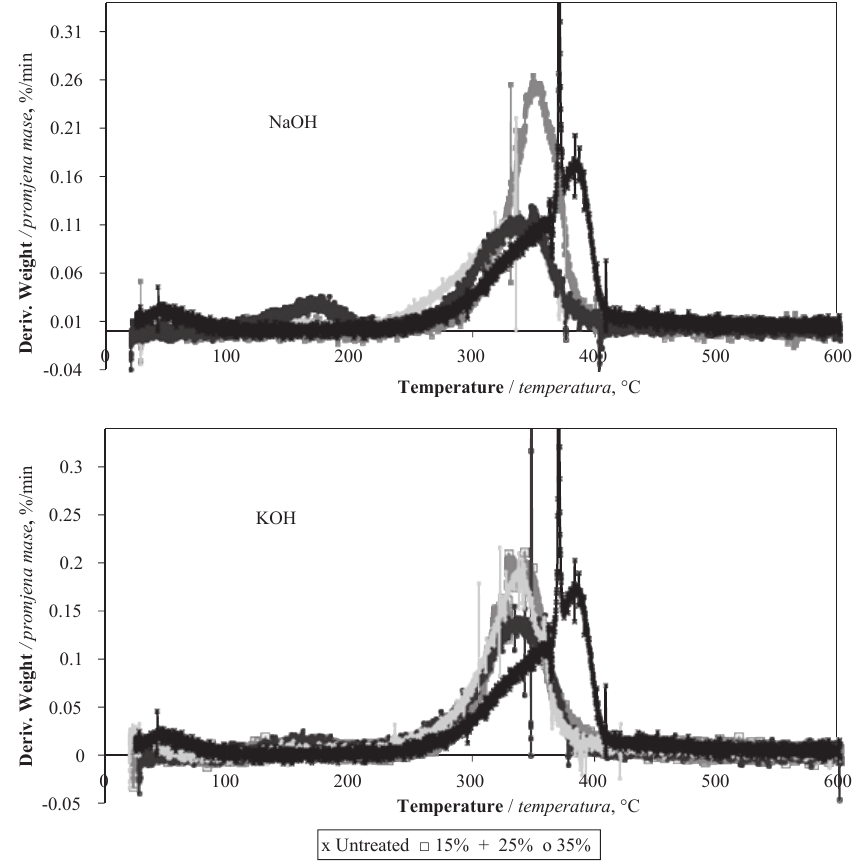
Figure 7 DTGA thermogram of untreated and benzylated wood with different alkali